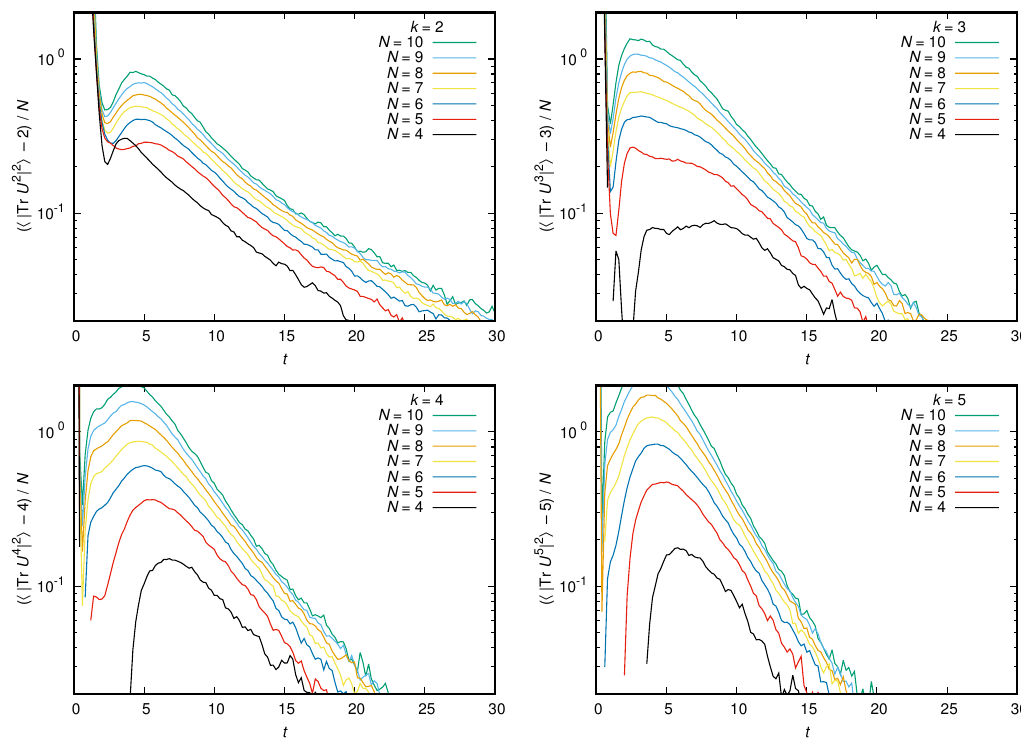
Figure 22 . Plot of ( hj Tr U k j 2 i (cid:0) k ) =N 2 against t for the local RCQ chain with dt = 0 : 2 for N = 10 ; 9 ; 8 ; 7 ; 6 ; 5 ; 4 qubits, k = 2 ; 3 ; 4 ; 5. An exponential (cid:12)t of the N = 9 curve is also